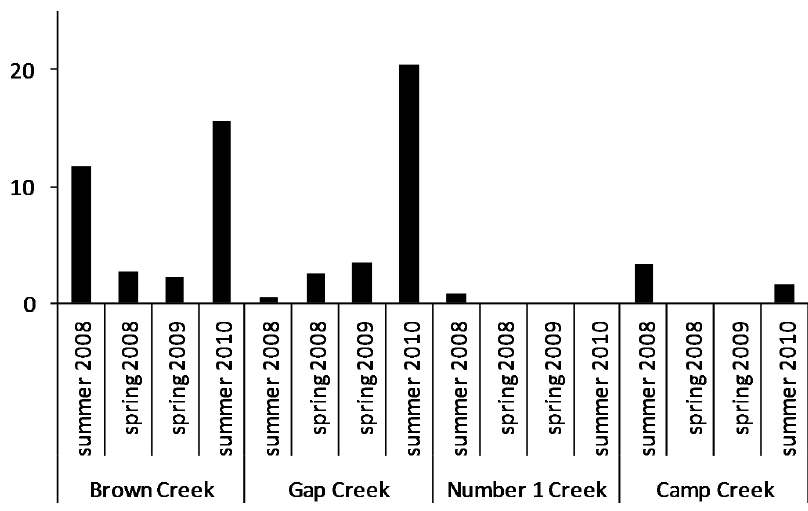
Figure 3. Geocharax sp. nov. 1 abundance for each stream per 100 m sampling effort.